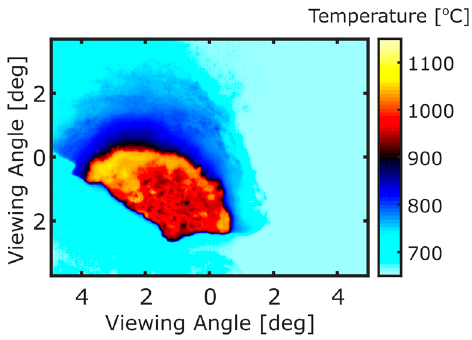
Figure 5. A PiCam image of the Masaya lava lake, taken on 12 June 2017 at 18:12:20 UTC. Lake temperatures of up to 1059 ± 14 °C are observed here. Temperatures are highest towards the edges where collisions with the crater wall appear to occur and elsewhere in the lake when bubble bursts expose fresh magma. The high apparent temperature of the crater wall is due to reflection of the lake’s radiation, either by aerosols or by the wall itself; these temperatures are, therefore, inaccurate. General interrogation of the thermal imagery and associated ROI time series, taken on 12 June from 18:12:20 to 18:44:48 UTC, indicates a mean lava lake temperature, averaged over both space and time, of ≈ 970 °C (Figure 6). The uncertainty associated with a single pixel at this temperature is ±12 °C; however, since here a mean temperature is quoted, this uncertainty is not directly applicable. Freshly exposed magma, from bubble bursting events or collision of the lake with the crater wall, reaches temperatures of up to ≈ 1104 ± 14 °C, which is relatively consistent with temperatures recorded for molten basalts at other lava lakes (e.g., [3,12,35,36]).